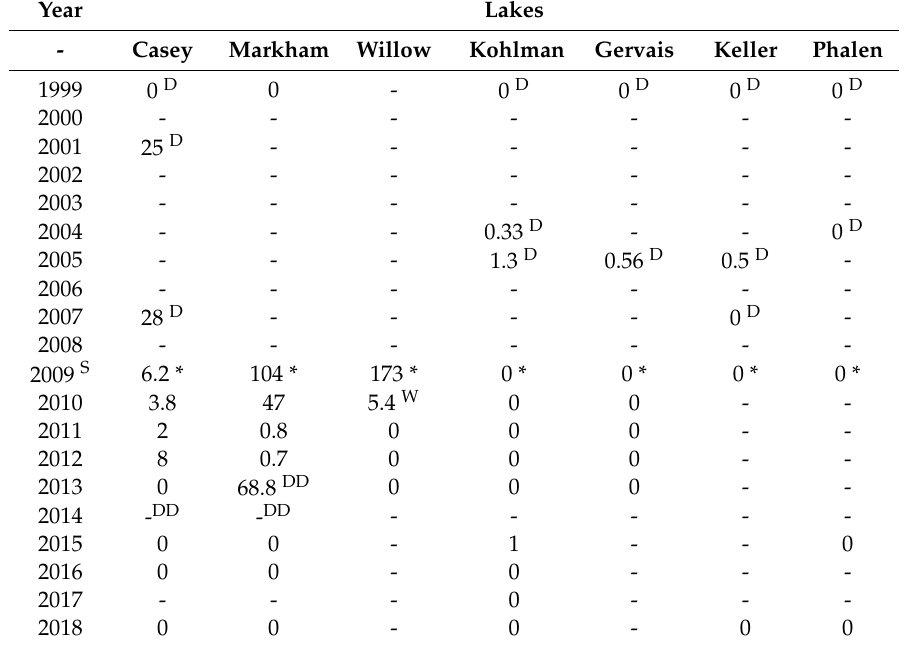
Table 4. Average number of Young-of-Year (YOY) carp caught per trap-net (CPUE) in the Phalen Chain of